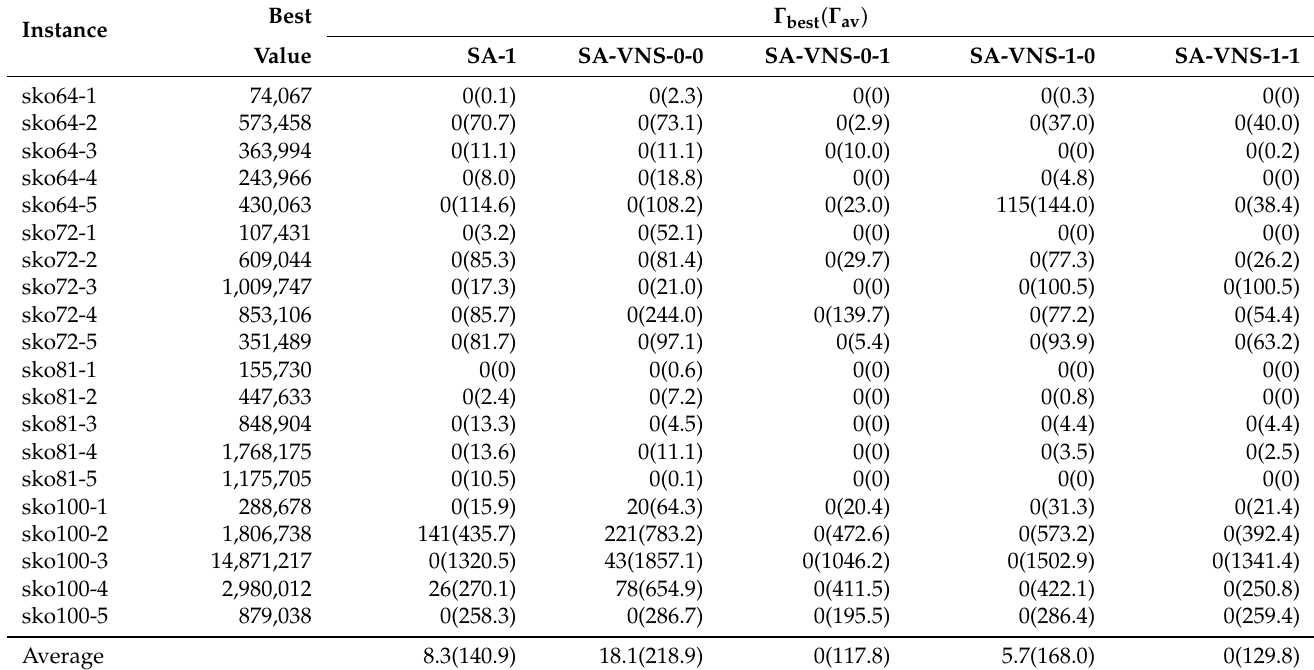
Table 2. Comparison of the objective function values for the adapted sko instances: best ( Γ best ) and average ( Γ av ) solution gaps to the best result.